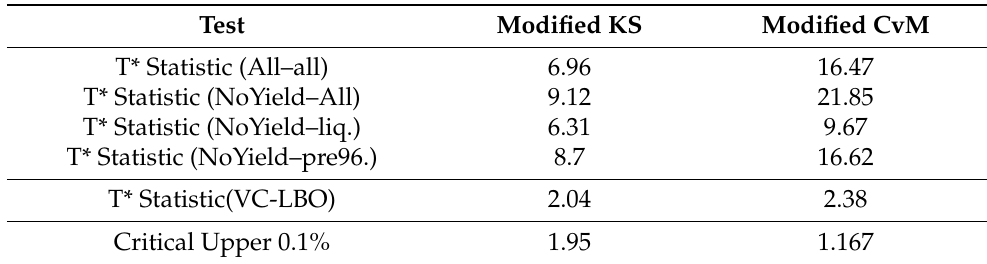
Kolmogorov–Smirnov and Cramér–von Mises statistics) and corresponding 0.1% critical value re- ported in R.B.D (cid:48) Agostino and M.A.Stephens. Goodness-of-Fit Techniques . NewYork: Marcel